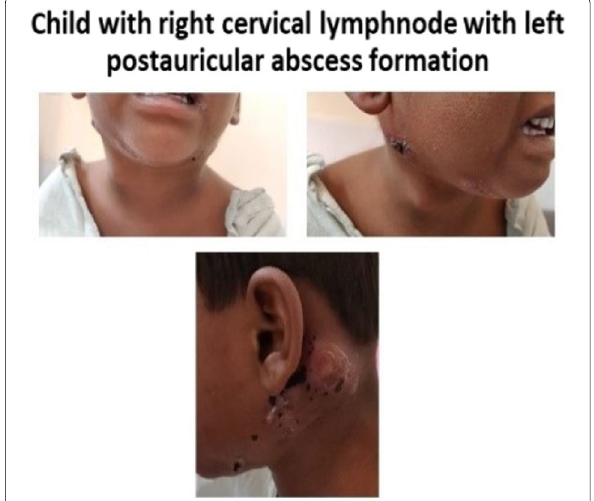
Fig. 3 Tuberculosis cervical